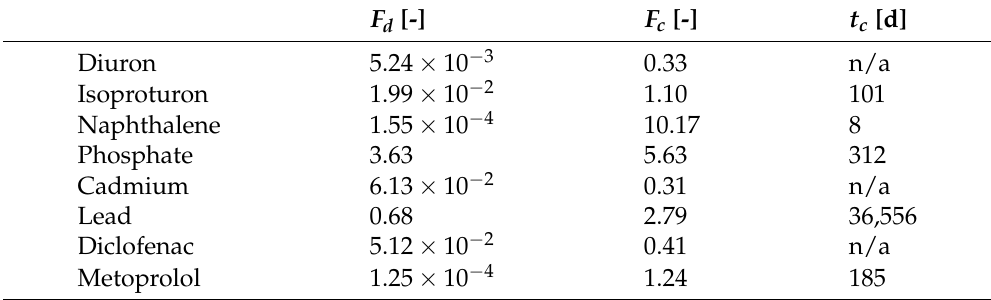
Table 3. The sustainability indices for each contaminant, showing the discrepancy factor F d , the critical sustainability factor F c , and the critical sustainability time t c . The latter is only defined for contaminants whose quality standards are exceeded.